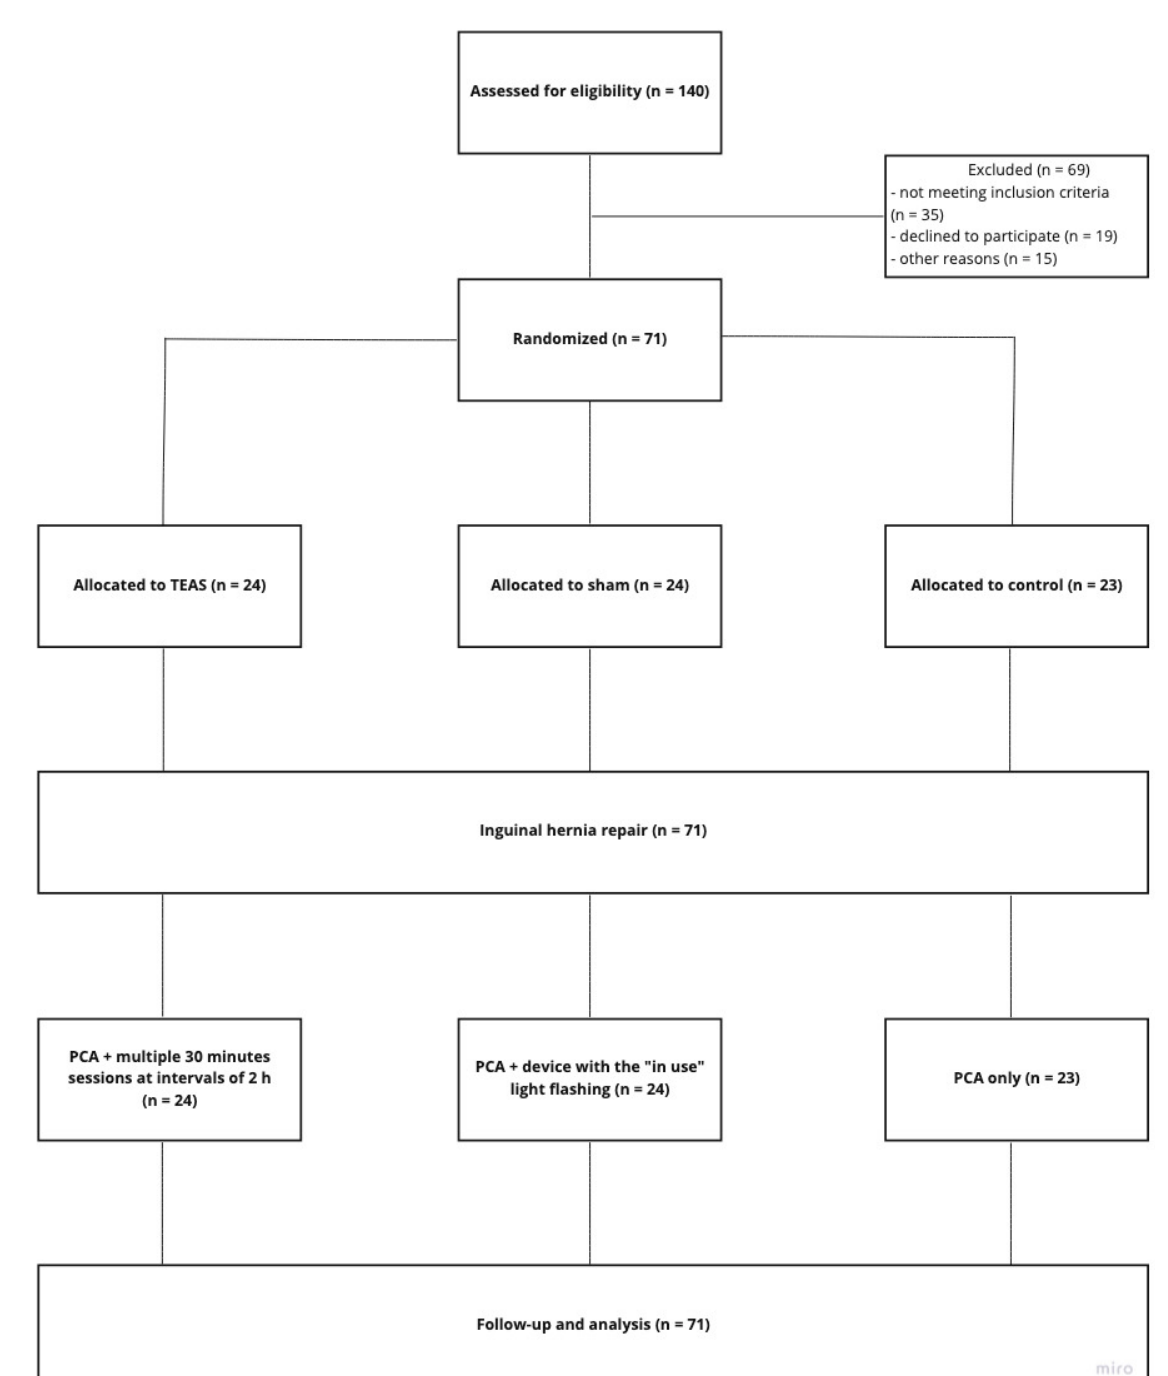
Figure 1. Schematic presentation of the study with special regard to the classification of enrolled participants. TEAS— transcutaneous acupoint electrical stimulation; PCA—patient-controlled analgesia.